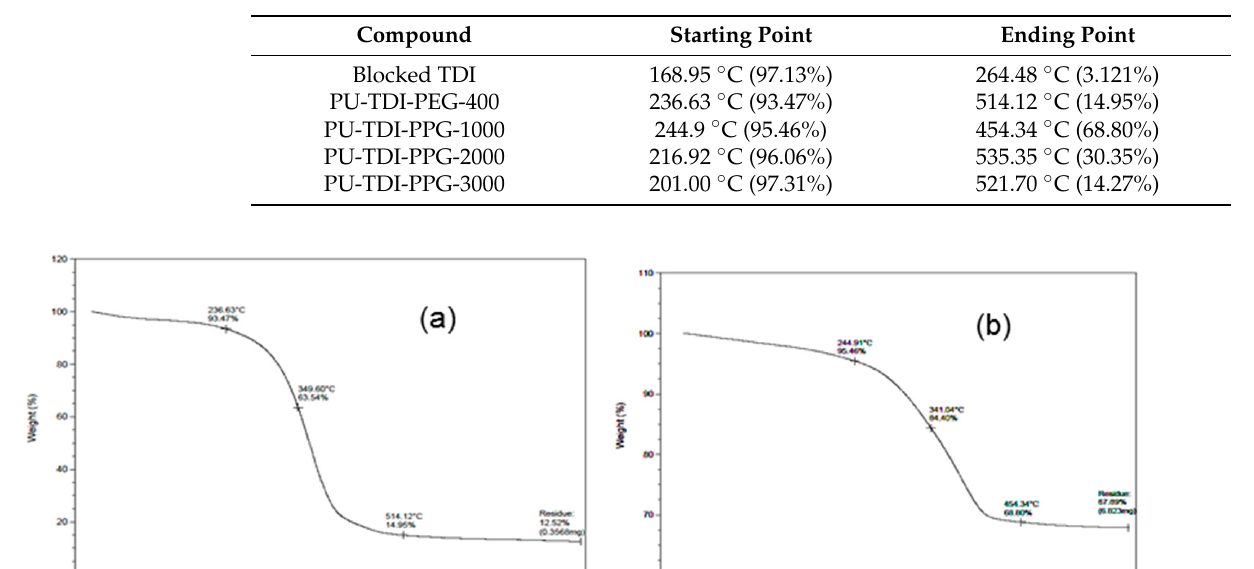
Table 7. TGA thermogram of the mentioned compounds.